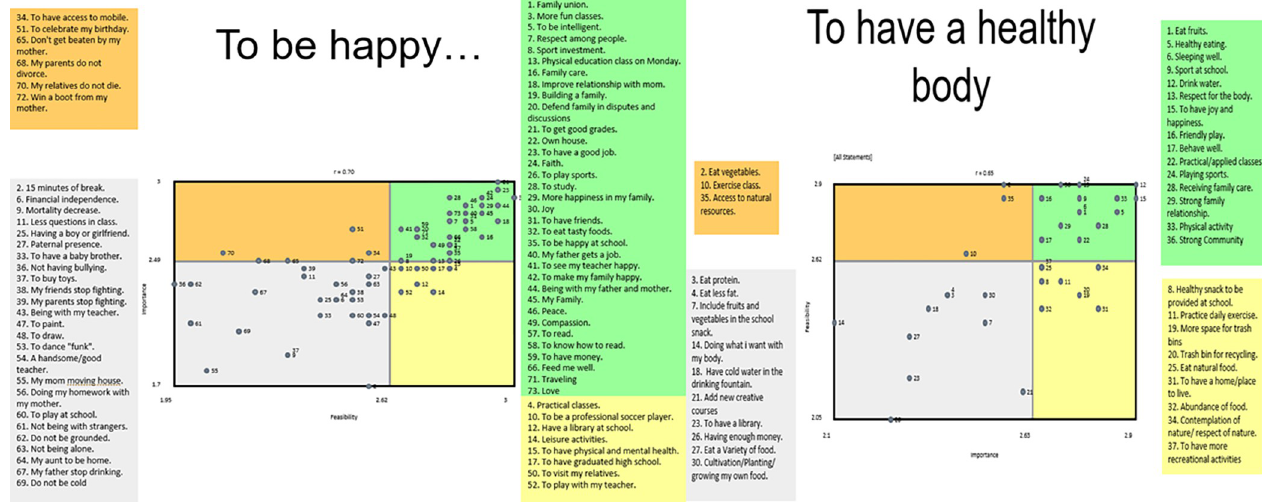
Fig 3. Youth Go-zone map based on their perspectives on important and feasible actions in response to the prompt ‘To be happy it is necessary to ... ’ And “To have a healthy body it is necessary to ... ” Coloured circles indicate to what cluster each statement belongs.